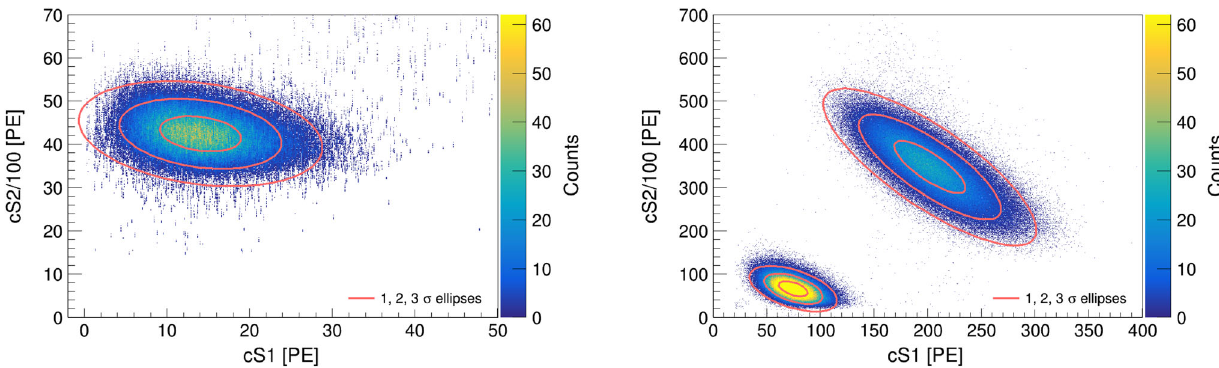
( a ) 2 . 82keV line of 37 Ar. The charge and light anti- correlation is moderated at this low energy. Fig. 9 Low energy populations of both sources in total S2 versus total S1 space showing a charge and light anti-correlation. The data was acquired at a drift field of 968V/cm. The ellipses show the 1 , 2 , 3 σ regions of the distribution